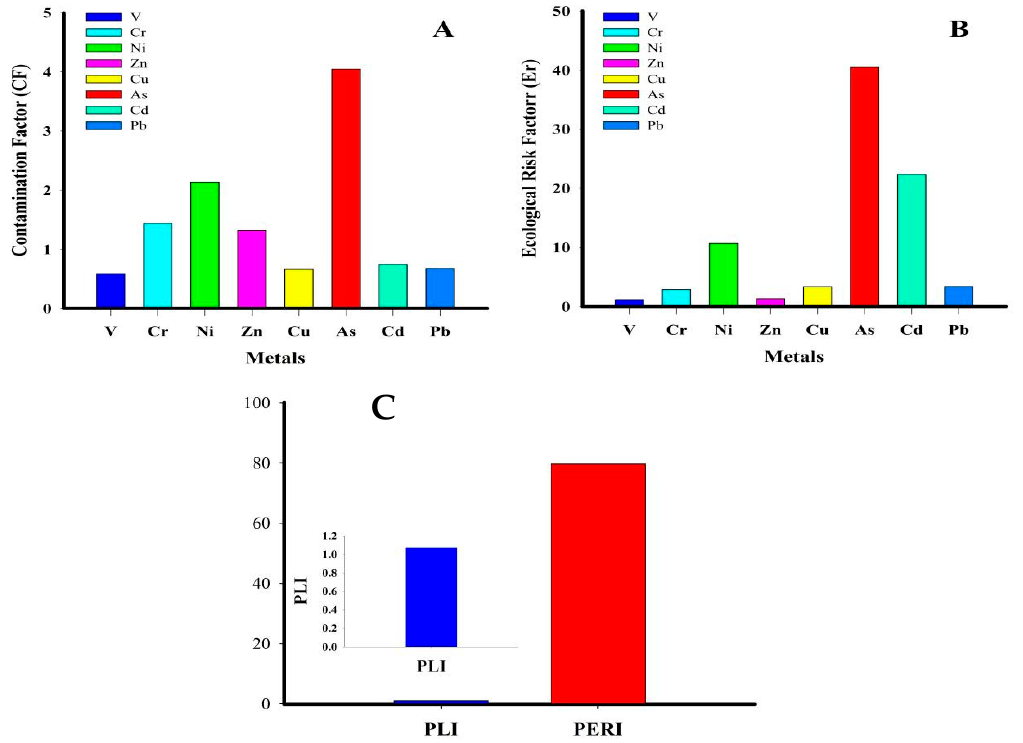
Figure 3. ( A ) Metals contamination factors (CF); ( B ) ecological risk factors (Er); ( C ) pollution load index (PLI) and potential ecological risk (PERI).